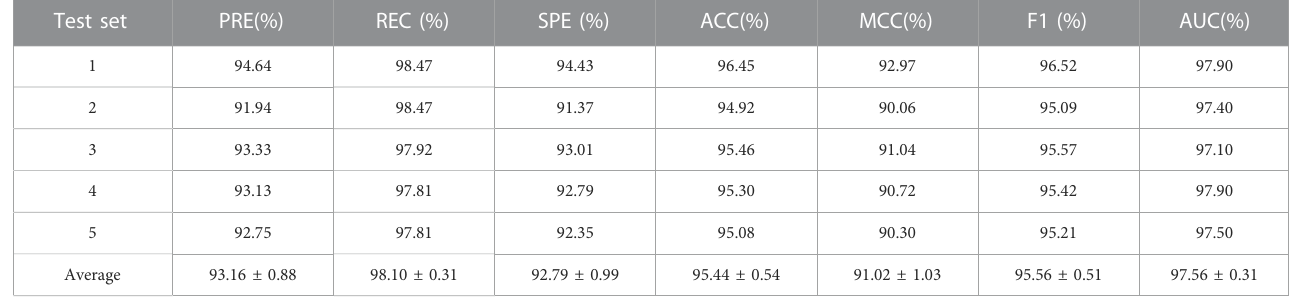
TABLE 1 5-fold cross-validation results for